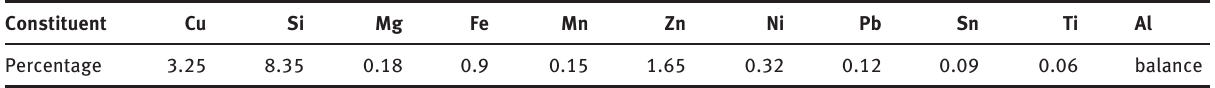
Table 2 Chemical composition of aluminium alloy in weight